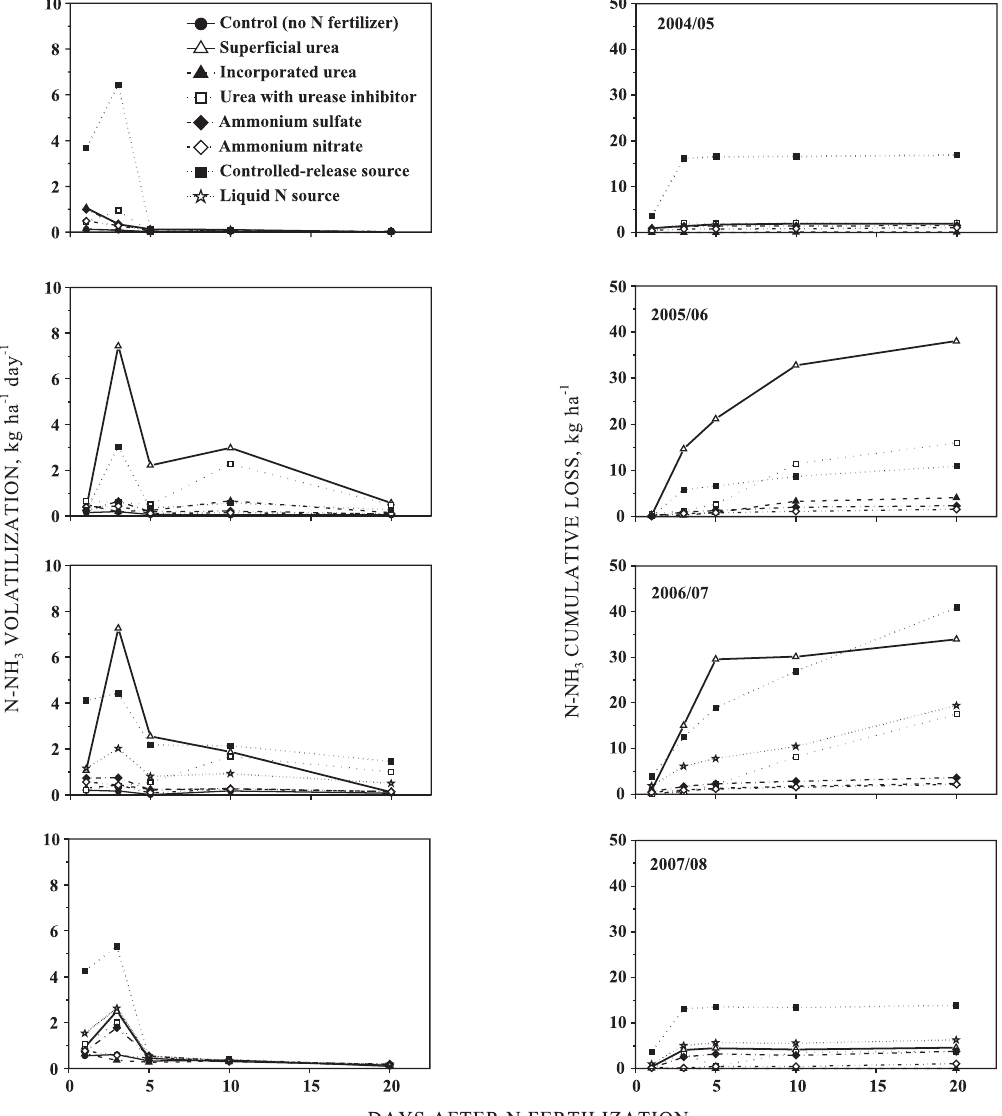
Figure 2. Rate and cumulative loss of N-NH by volatilization during four harvest seasons (2004/05, 2005/06, 3 2006/07 and 2007/08) of no-till corn treated with urea (superficial and incorporated) and other N sources in Guarapuava,